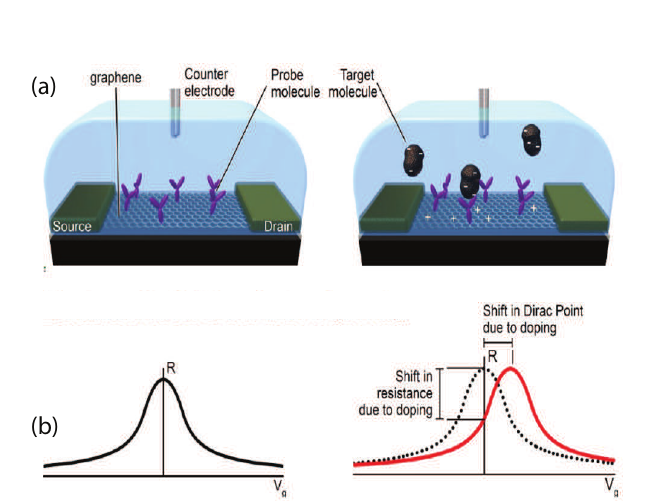
Figure 15. ( a ) representation of a functionalized graphene Bio-FET and binding of charge target molecule; ( b ) the binding of the molecules alter graphene Fermi level. As a result, the Dirac point is shifted and thus a modification is observed in the calculated resistance. Reprinted with permission from [140]. Copyright (2012) American Chemical Society.